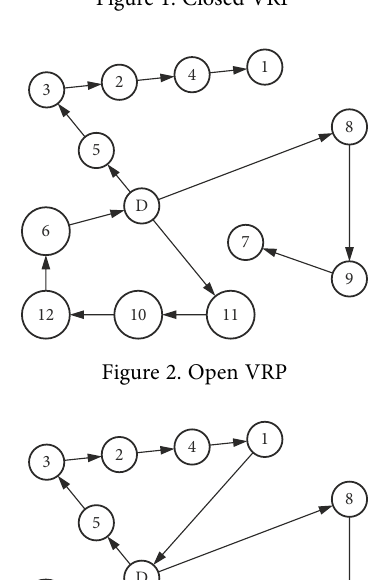
Figure 1. Closed VRP